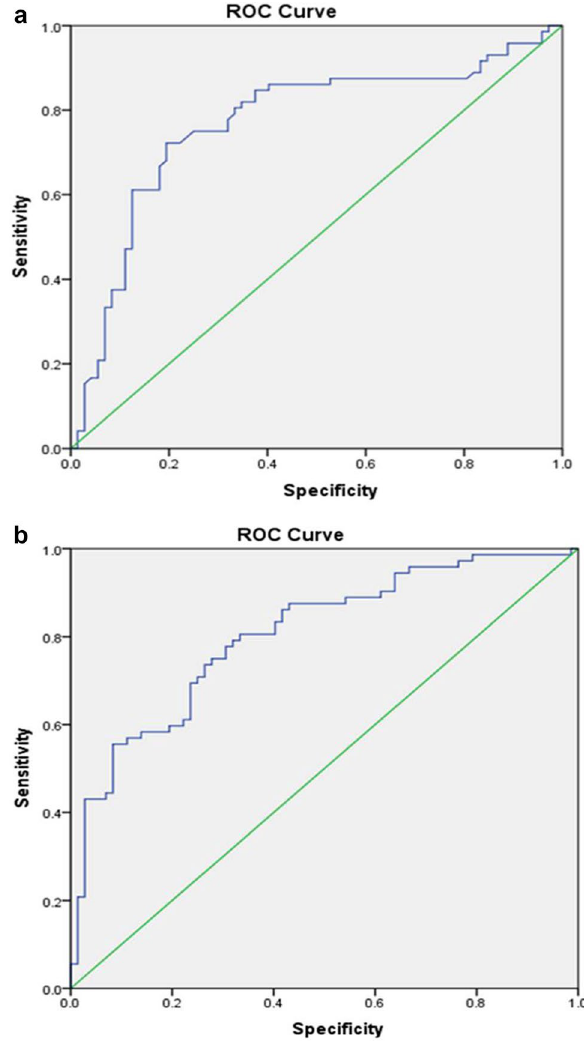
Figure 1. ( a ) Receiver Operating Curve showing predictive role of baseline Visfatin for incident diabetes. The median value of Visfatin was 17.7 ng/ml (sensitivity 75%, specificity 75% p < 0.0001). AUC = 0.77 ± SE 0.4 (95%CI 0.69–0.85). ( b ) Receiver Operating Curve showing predictive role of baseline Fetuin-A for incident diabetes. The mean value of Fetuin-A was 235.5 µg/ml (sensitivity 71%, specificity 75% p = < 0.0001). AUC = 0.80 ± SE 0.04 (95%CI